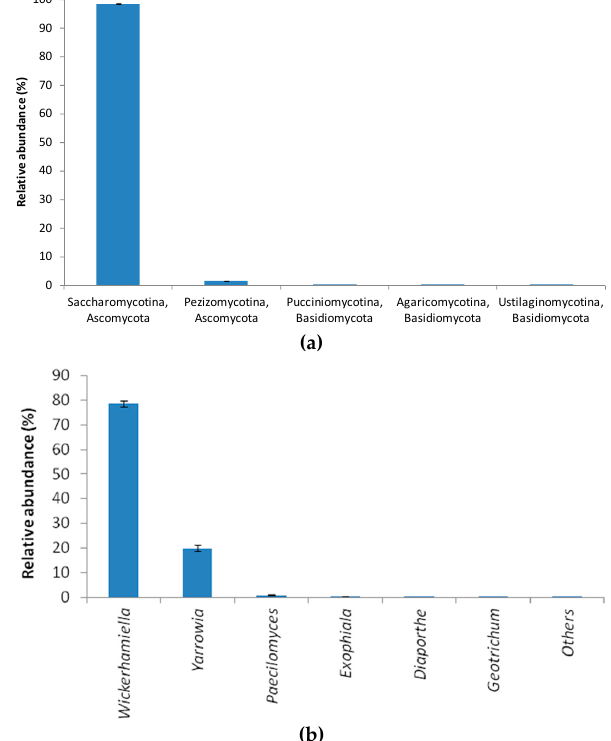
Figure 6. Relative abundances (% of total fungal reads) at ( a ) phylum/subphylum and ( b ) genus level of the major fungal taxa in the immobilized cell biofilter treating diclofenac-based wastewater.